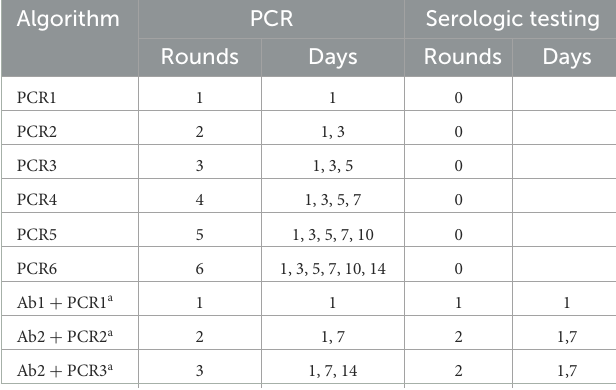
TABLE 1 The screening algorithm for SARS-CoV-2